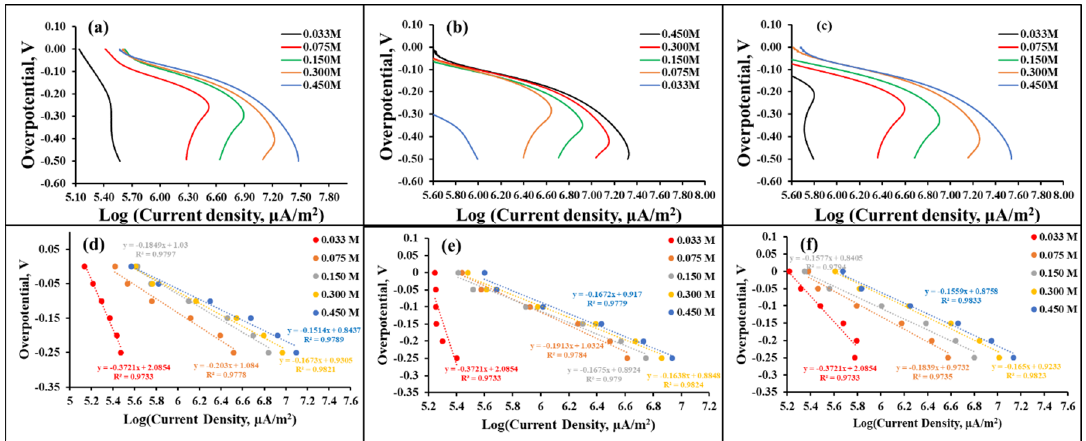
Figure 6. Tafel plots for ( a ) PABA, ( b ) CoZIF and ( c ) the PABA/CoZIF composite, and typical linear polarization curves from the Tafel plots for ( d ) PABA, ( e ) CoZIF and ( f ) the PABA/CoZIF composite in the presence of 0.033–0.450 M H 2 SO 4 at 0.10 V s −1 on a Au electrode in 0.1 M TBAP/DMSO electrolyte.